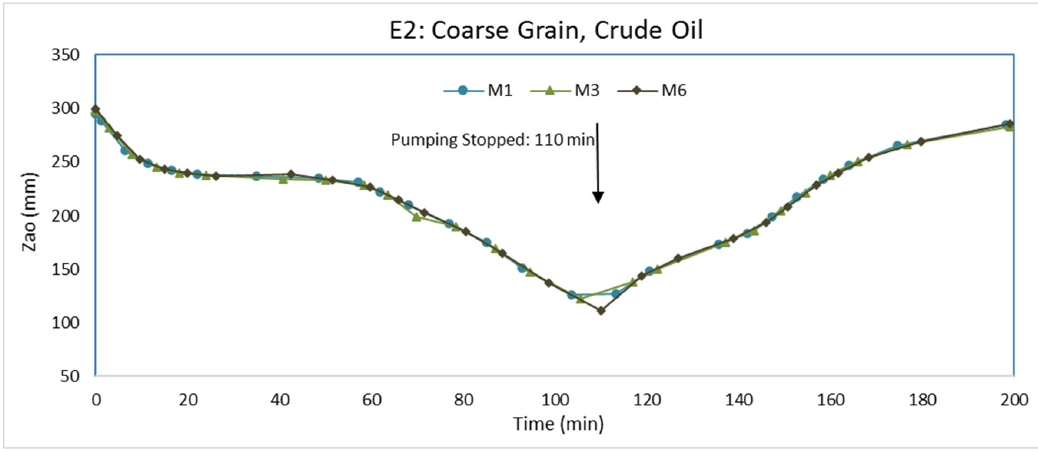
Figure 8. Air-LNAPL interface elevation (Zao) variations in E2.